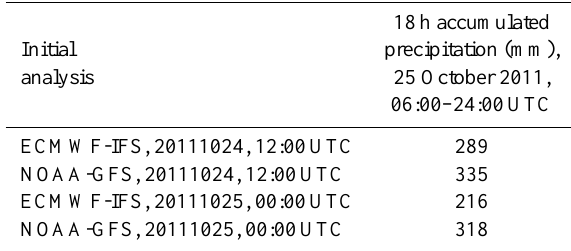
Table 1. Absolute maxima of precipitation in the BOLAM runs, for the CT event, corresponding to the initial conditions listed in the left column. The percentage of convective precipitation contributing to the maxima is reported in the right column (in parentheses).